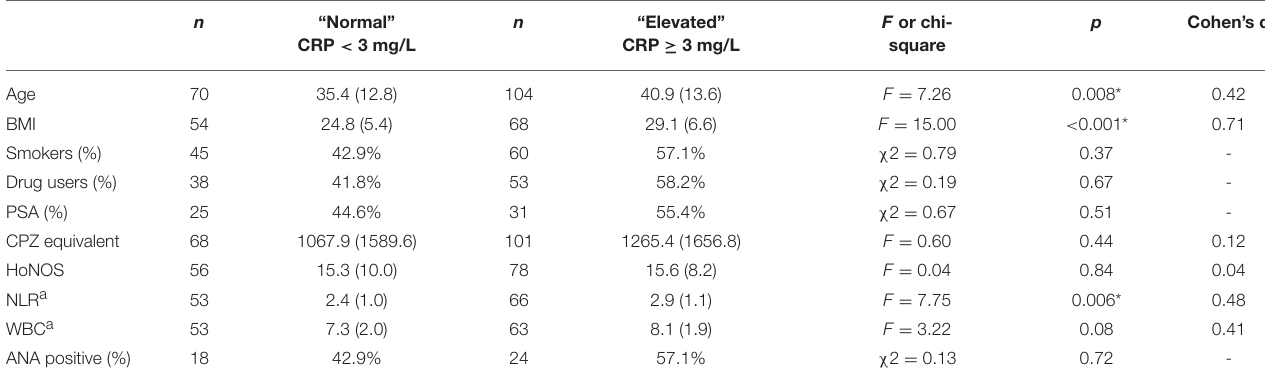
TABLE 4 | Characteristics of the acute psychosis sample in the normal (CRP < 3 mg/L) and elevated (CRP ≥ 3 mg/L) CRP groups.